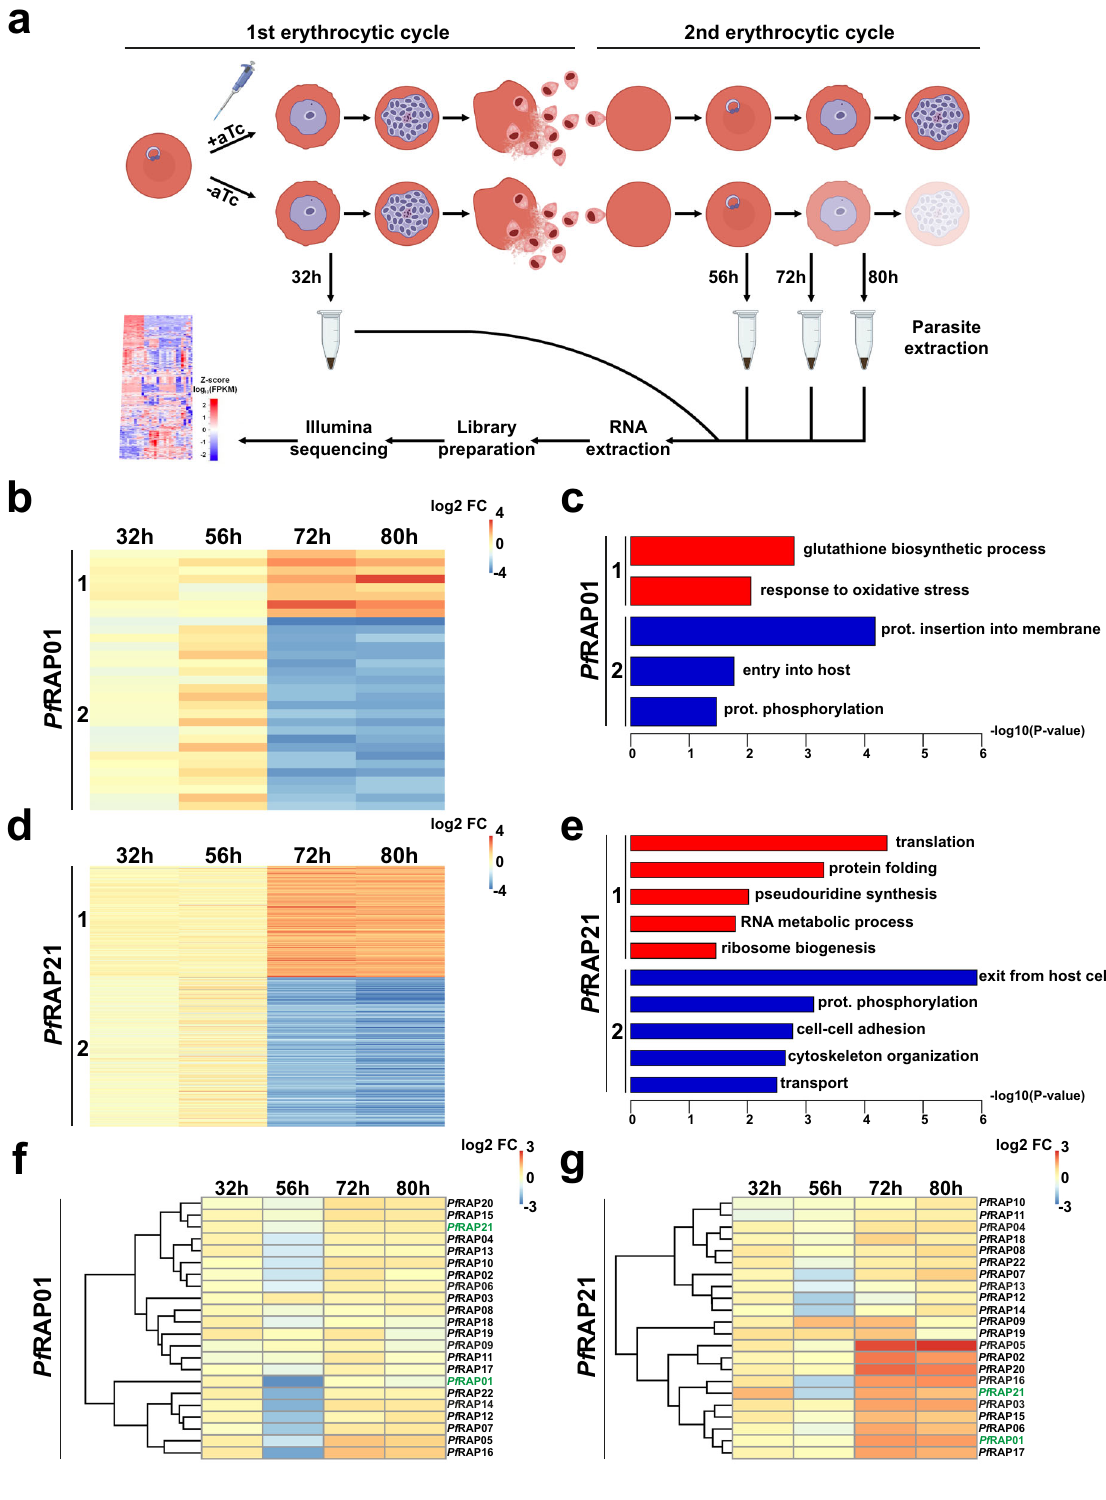
Fig. 4 Transcriptome pro fi le of Pf RAP01 and Pf RAP21 knockdown parasites. a The schematic illustrates the key steps of the RNA-seq protocol. Created with BioRender.com. b – d Clustering of signi fi cantly affected genes from Pf RAP01 ( b ) and Pf RAP21 ( d ) knockdown parasites. Clusters 1 and 2 regroup genes signi fi cantly up-regulated and down-regulated respectively (two-tailed Wald test with Benjamini – Hochberg adjustment). c – e GO enrichment analysis of genes with − log10 ( p value) for clusters 1 (red) and 2 (blue) (weight01 Fisher test). Heatmaps of the log2 FC values of predicted RAP proteins from Pf RAP01 ( f ) and Pf RAP21 ( g ) knockdown